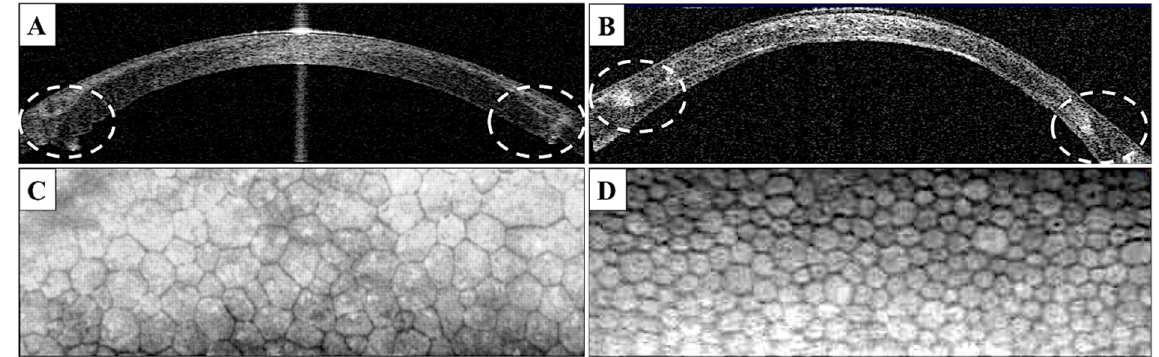
Figure 4. (A , B ) — Anterior OCT Visante presenting the donor – host junction interaction after PK ( A ) and DALK ( B ), noticeable precise adjustment of the wound with no posterior folds visible in the DALK OCT scan, in contrast to a mismatch of the donor – host junction after PK. ( C , D ) — endothelial cell photographs from a specular microscope 12 months after PK ( C ) and DALK ( D ), visible different densities of endothelial cells, as well as polymorphism/polymegatism of the cells in the case of the PK patient.